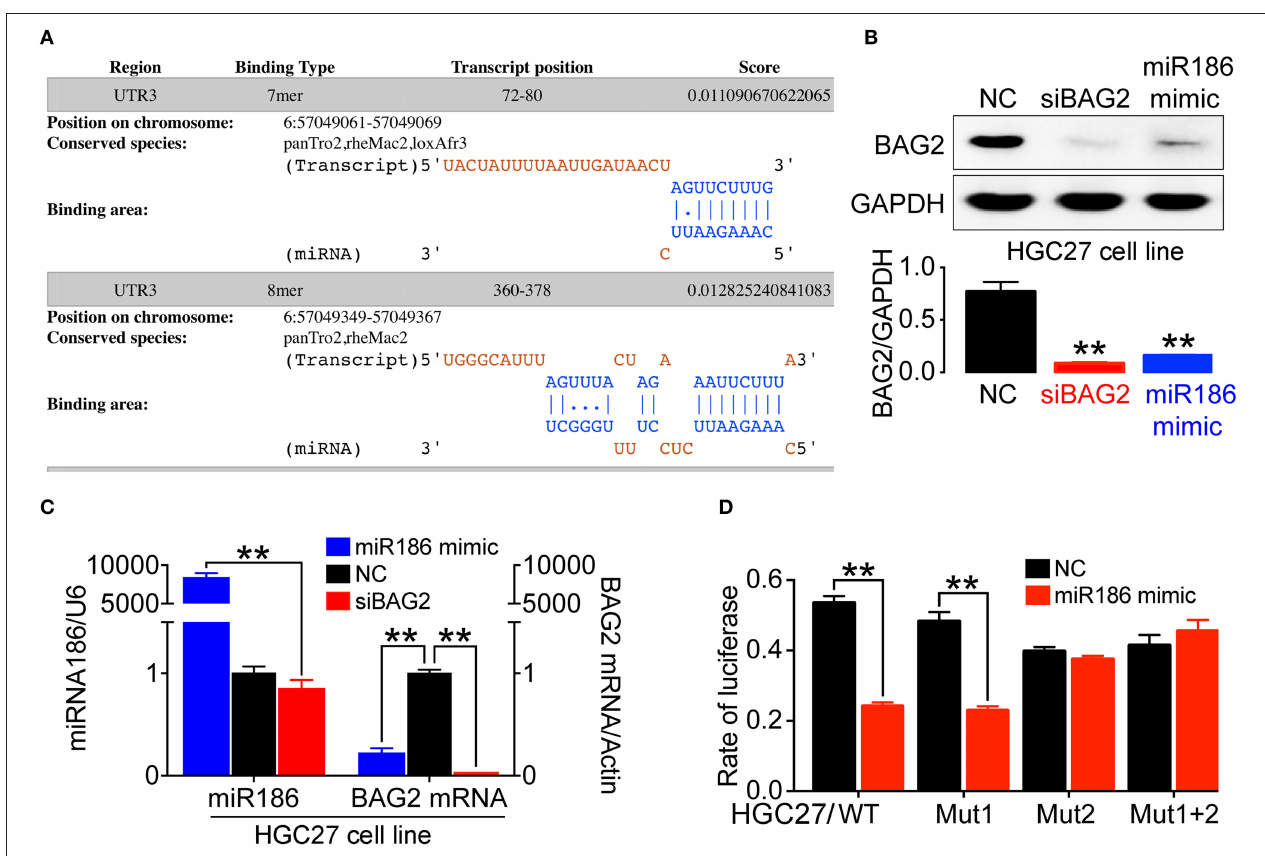
FIGURE 5 | The expression of BAG2 was regulated by miR186. (A) Prediction of two high score binding sites between miR186 and BAG2 -3 ′ UTR on DIANA website; (B) Overexpression of miR186 inhibits expression of BAG2 protein; (C) Overexpression of miR186 inhibited BAG2 mRNA; (D) The effect of miR186 on the activity of luciferase reporter containing BAG2- 3 ′ UTR-WT , BAG2 -3 ′ UTR-Mut1 , BAG2 -3 ′ UTR-Mut2 or BAG2 -3 ′ UTR-Mut1 + 2 was tested by luciferase reporter gene (** p <